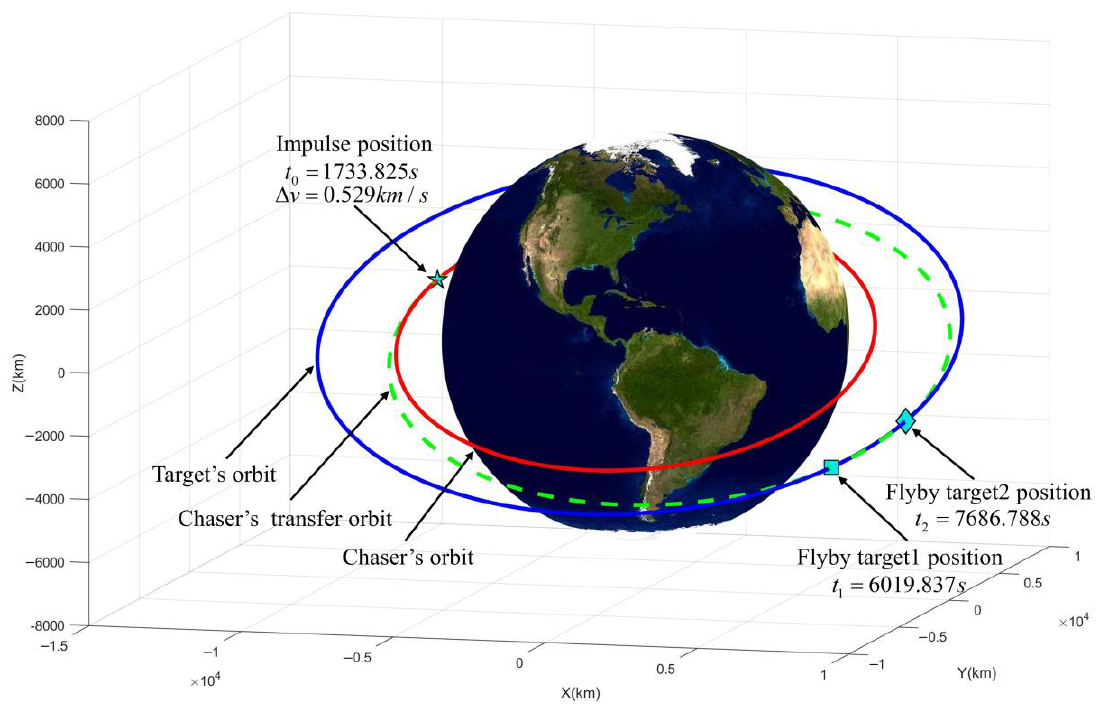
Figure 8. The minimum fuel solution of case